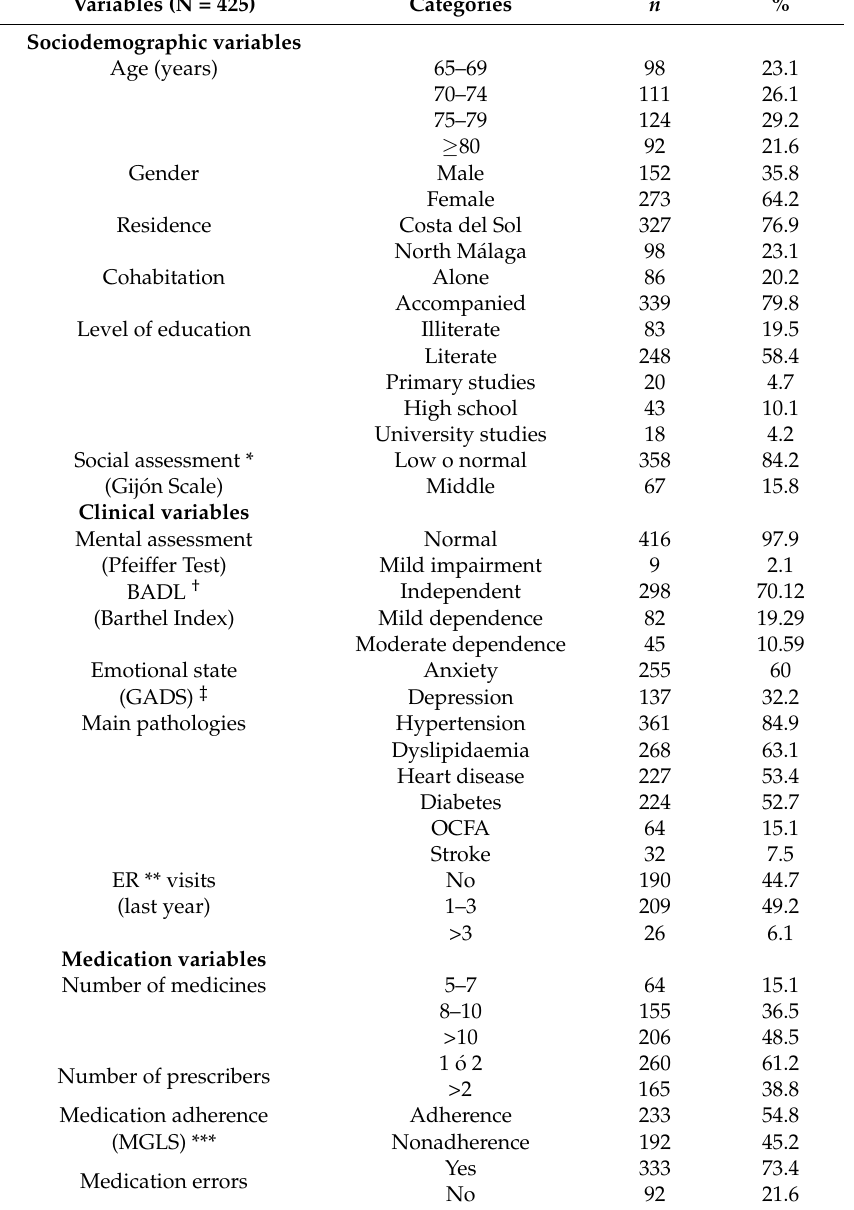
Table 1. Study variables and description of the